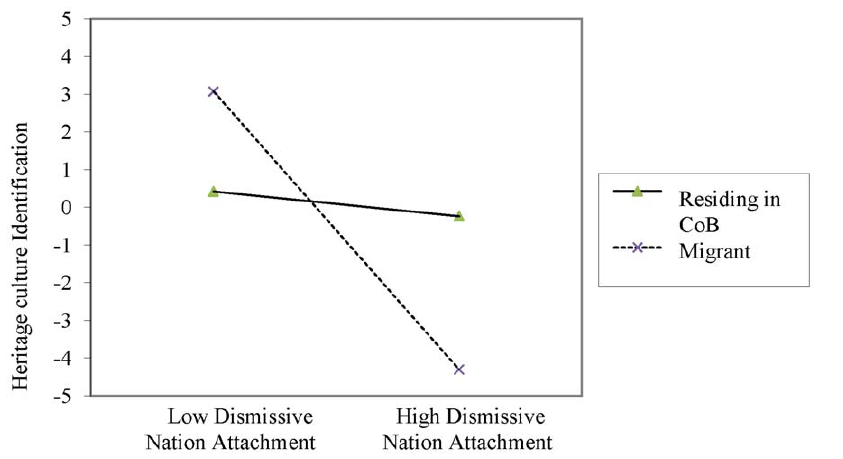
Figure 1. Interaction between resident status and dismissive nation attachment in predicting heritage culture identification levels in Study 1.